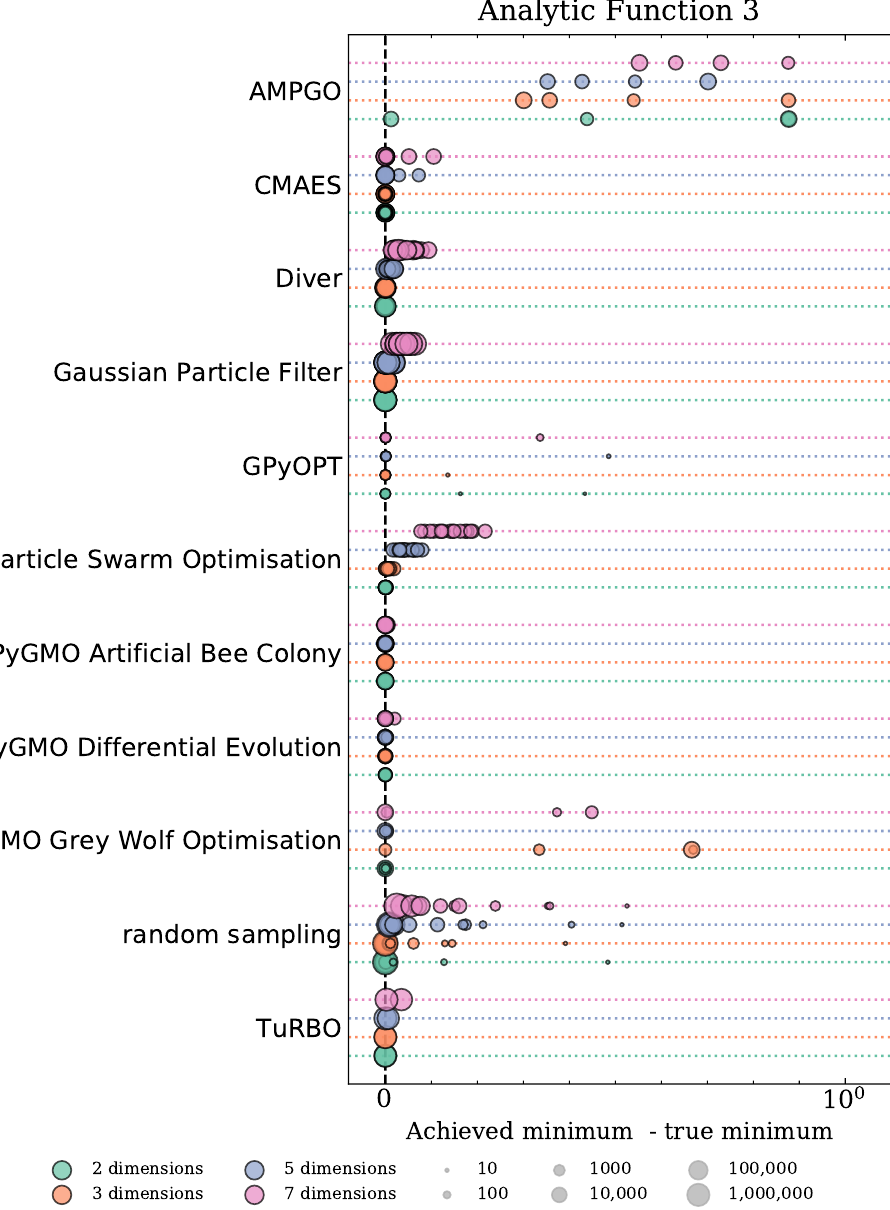
Figure 6. Results from different optimisation algorithms on the analytic function in equation (3.3). The results are shown as semi-opaque circles, of which the area increases logarithmically with the number of function evaluations needed to obtain that specific result. The four horizontal lines for each algorithm belong to the four explored dimensionalities, from top to bottom 7-dimensional (pink), 5-dimensional (purple), 3-dimensional (orange) and 2-dimensional (green). The horizontal axis shows the difference between the (known) log-likelihood at the global minimum and that at the found